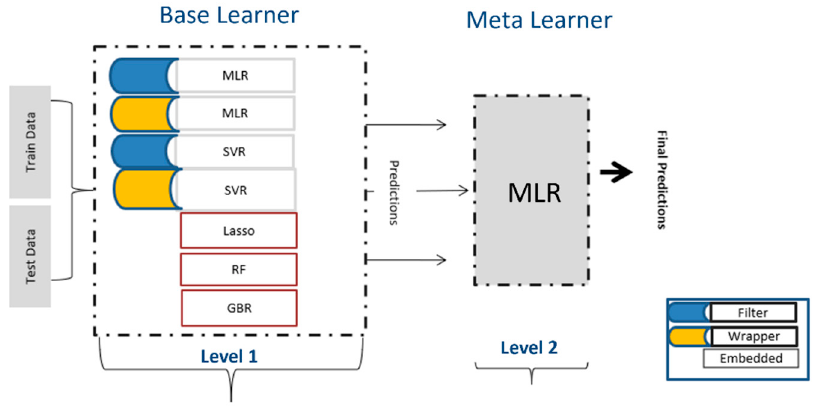
Figure 6. Architecture of Stacking used in this study.